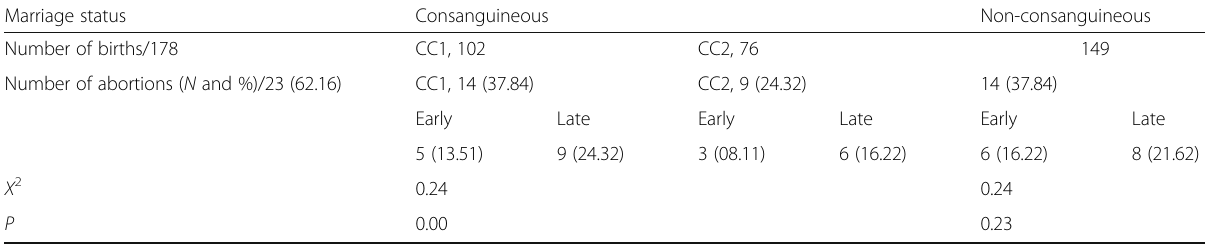
Table 3 Effect of consanguinity on